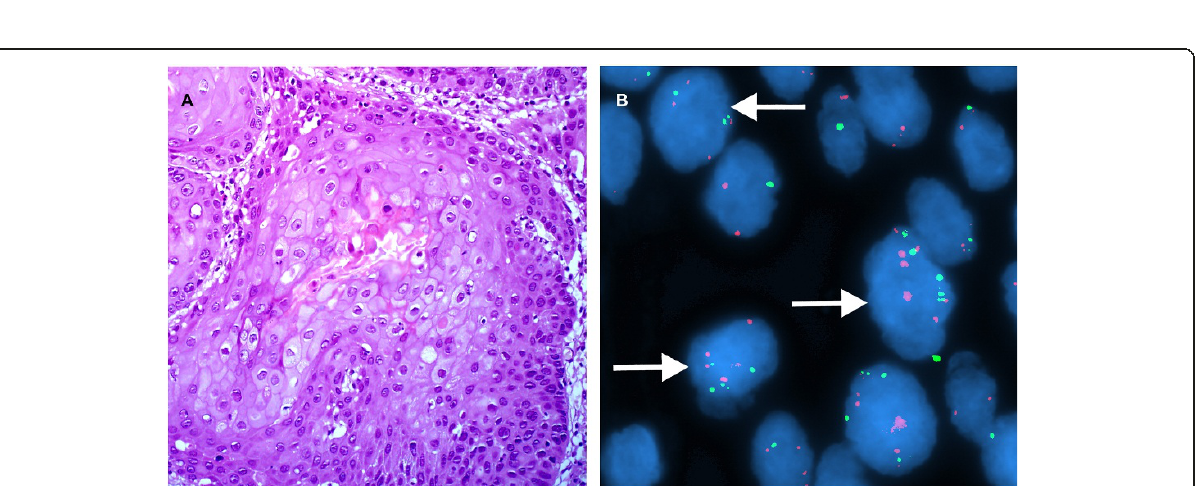
Figure 5 A case of carcinoma in situ . A. H&E stain. (×200). B. Interphase FISH displaying a CSP3: hTERC signal pattern is 2:3, 4:4, 6:6, and etc. (×1000).